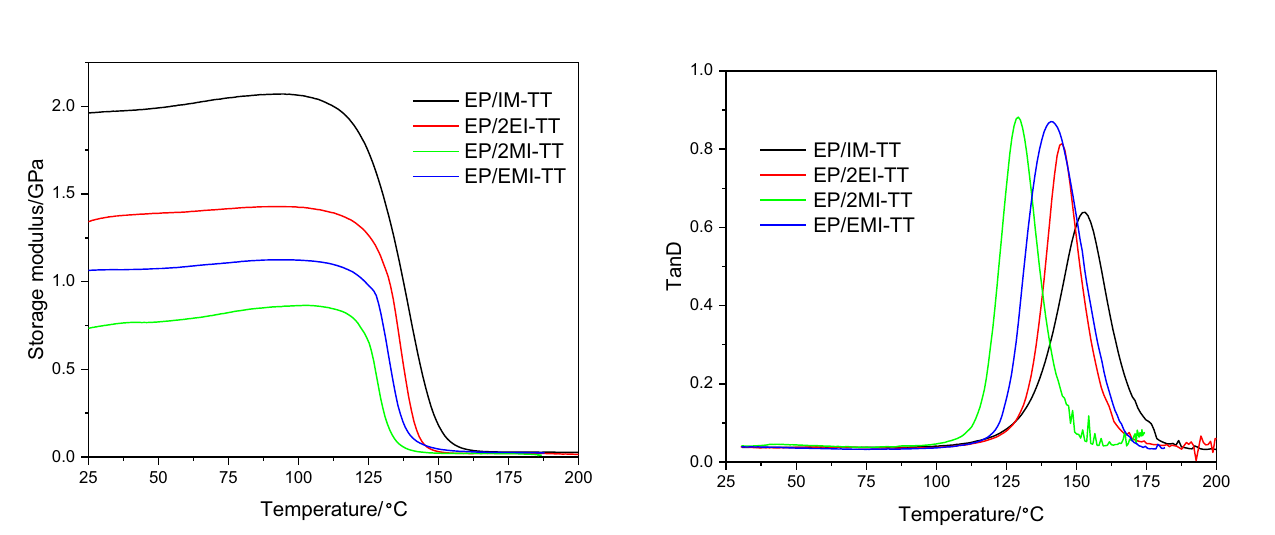
Fig. 10 Storage stability of the EP blends